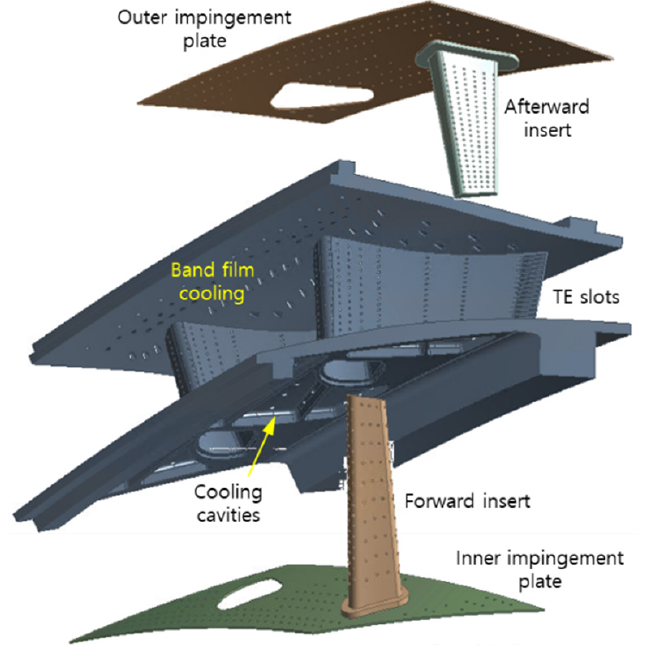
Figure 2. Base model—the first stage nozzle vane (reprinted with permission from [16]; copyright 2021 Korean Society for Fluid Machinery).